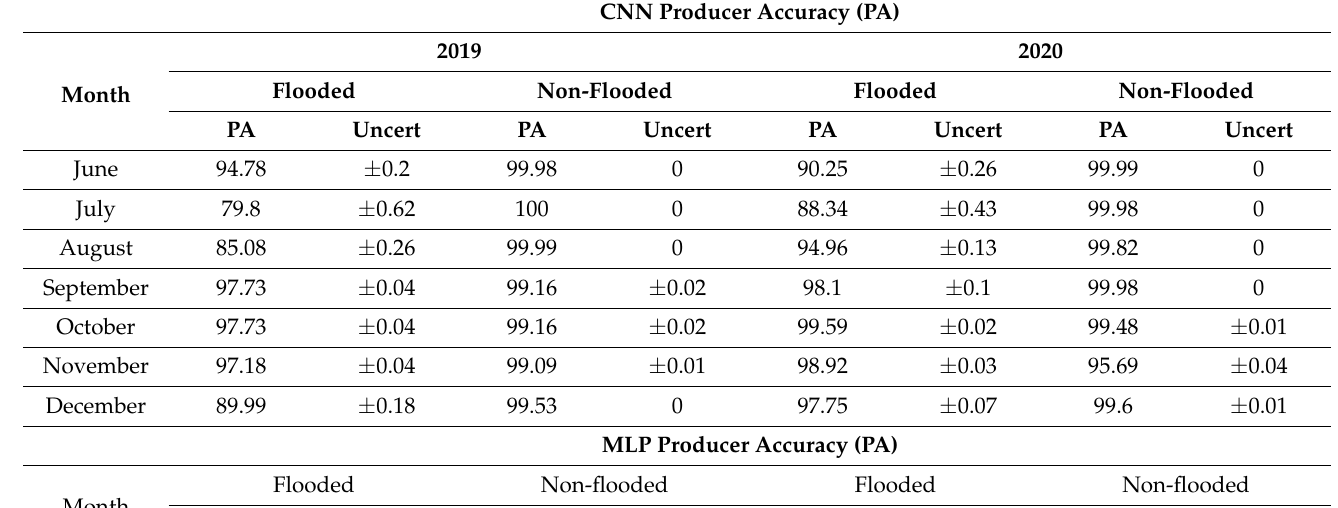
Table 6. PA and uncertainty of CNN, MLP and RF classifiers by month for the wet season. CNN Producer Accuracy